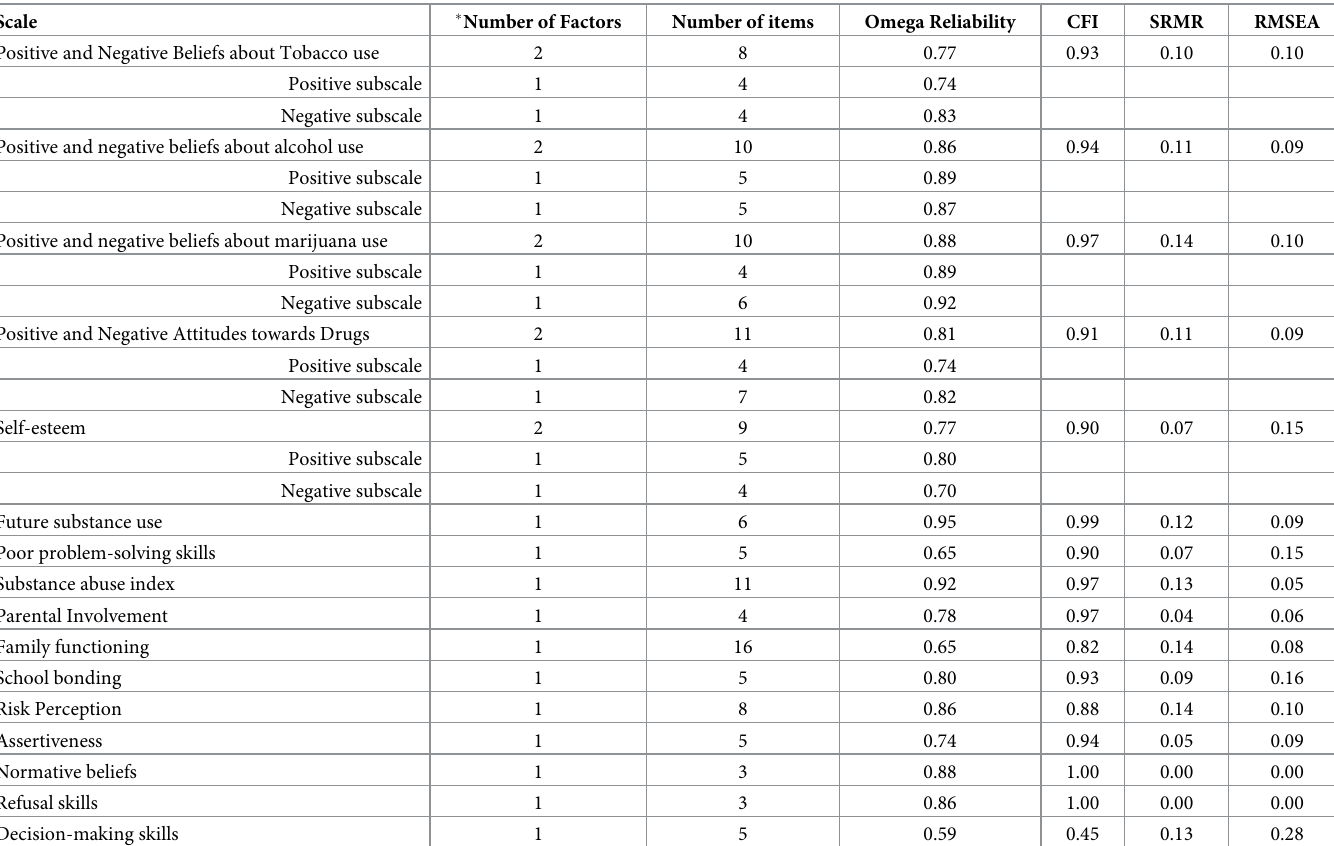
Table 4. Internal structure of the final scales and subscales of the EU-Dap